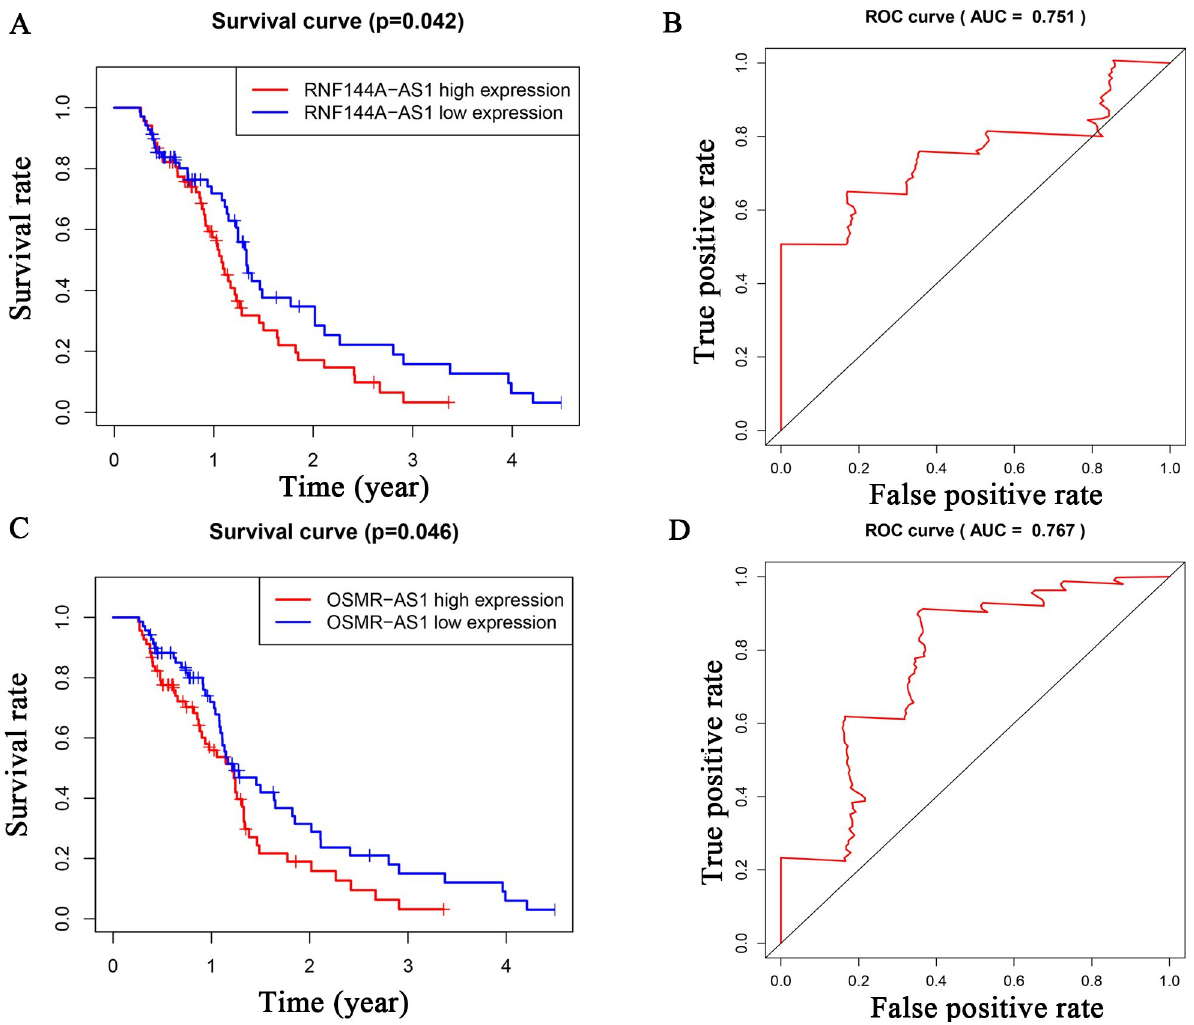
Fig 4. Kaplan–Meyer and ROC analyses of survival-related lncRNAs (RNF144A-AS1, OSMR-AS1). Kaplan-Meyer and ROC analyzed the relationship between lncRNAs and patient survival. We show two other statistically significant lncRNAs: RNF144A-AS1 (Fig 4A and 4B) and OSMR-AS1 (Fig 4C and